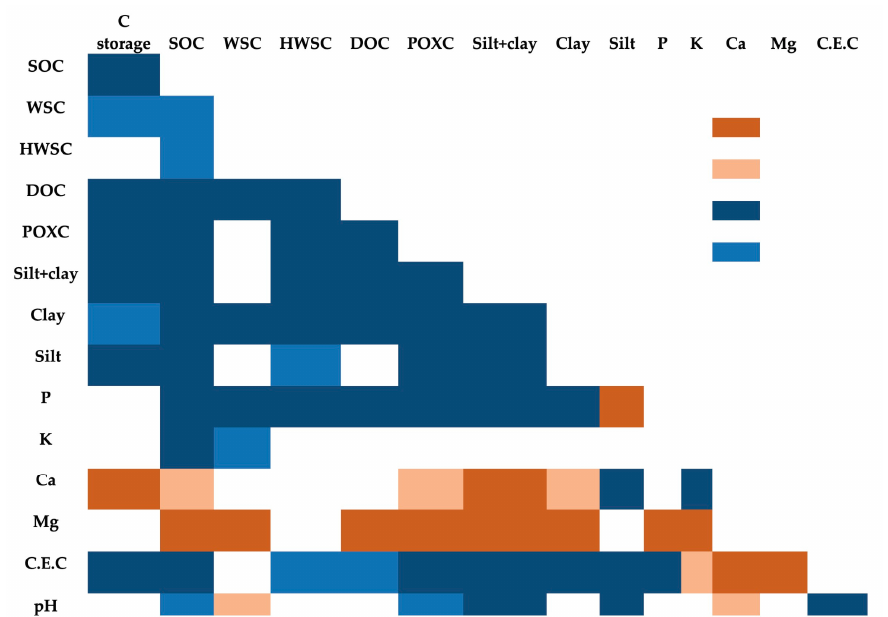
Figure 8. The correlation coefficient between carbon storage and SOC and other soil parameters under the RRCS. Note: Dark blue means a highly positive relation ( p ≤ 0.01–0.00), light blue means a low positive relationship ( p ≤ 0.01–0.04), dark brown means a high negative relationship ( p ≤ 0.01–0.00), light brown means a low negative relation ( p ≤ 0.01–0.04), and blank means no significant relationship.